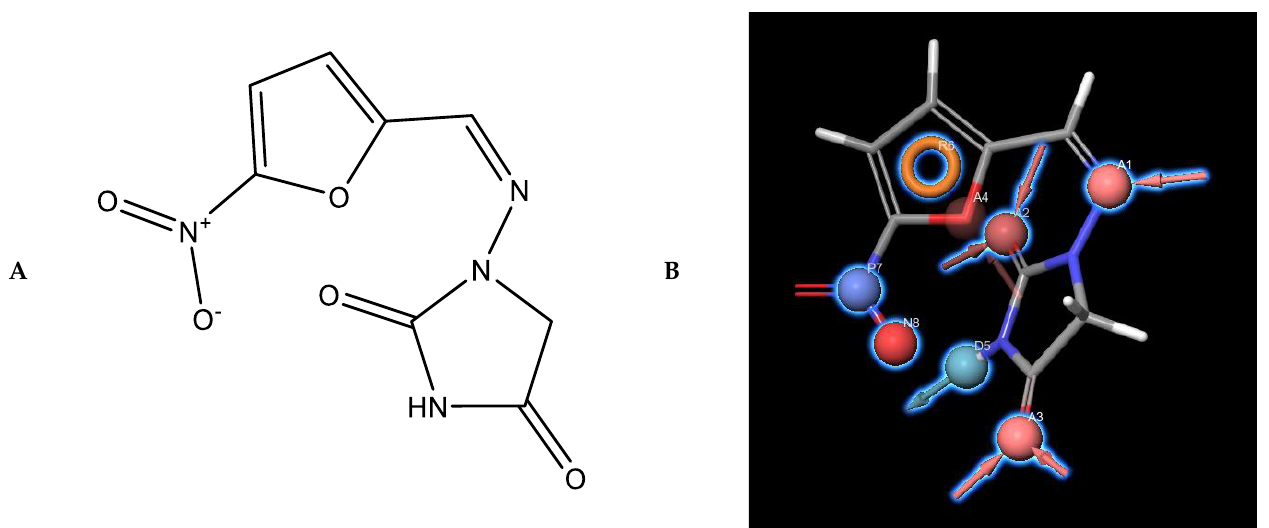
Figure 8. ( A ) Chemical structure of nitrofurantoin. ( B ) Nitrofurantoin superimposed with pharma- cophore features. Light red sphere: H-bond acceptor; light blue sphere: H-bond donor; red sphere: negative ionic; blue sphere: positive ionic; orange torus: aromatic ring.